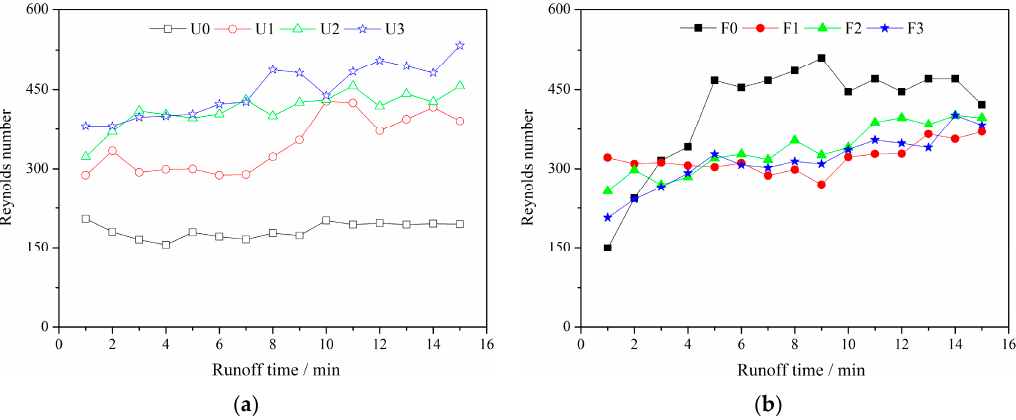
Figure 5. Variations in Reynolds number under different treatments over time. ( a ) Unfrozen slope, ( b ) frozen slope. ( b ) frozen